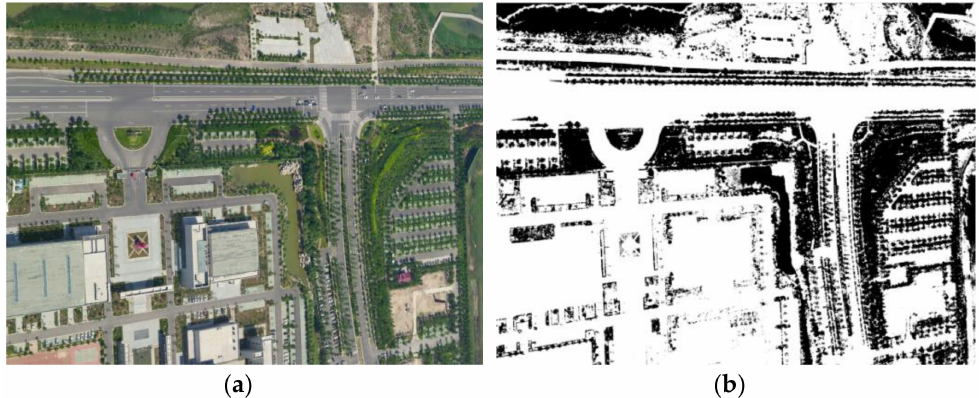
Figure 3. Recognition result of vegetation area. ( a ) Original oblique image and ( b ) recognition result of the vegetation areas (black parts, the gray value in the binary image is